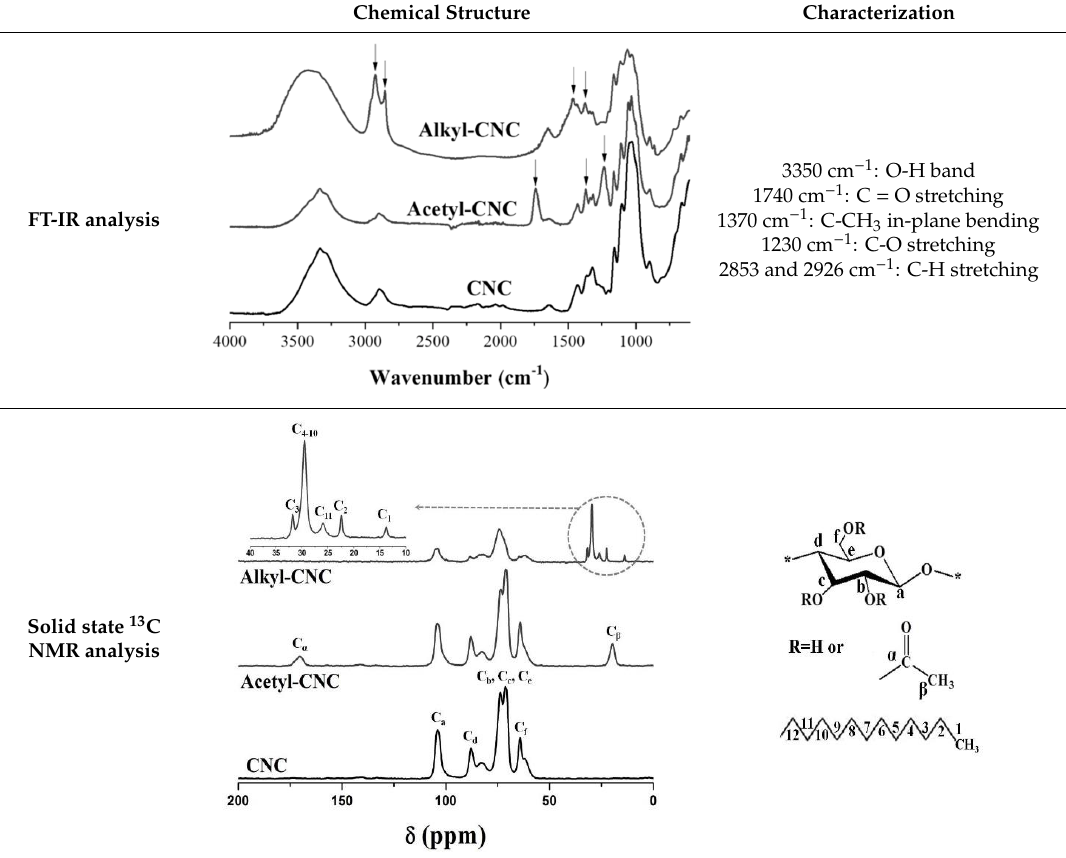
Table 1. The basic characteristics of surface modified CNC, identified by FT-IR and 13 C NMR.